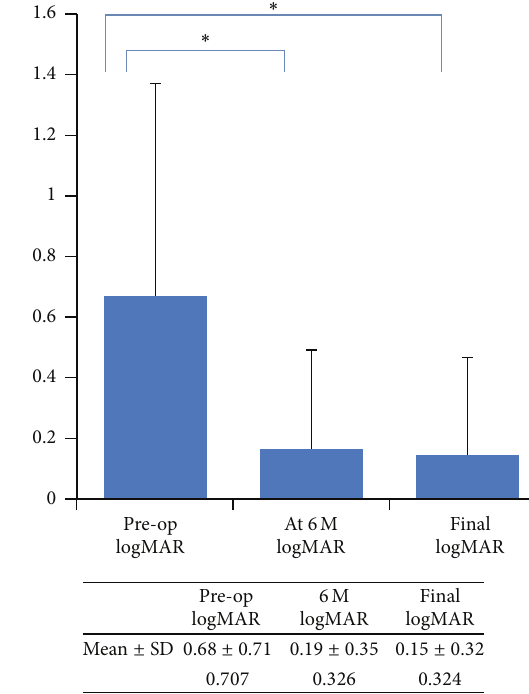
Figure 1: Log MAR of BCVA preop and postoperatively. ∗ Wilcoxon signed rank test 𝑃 < 0.001